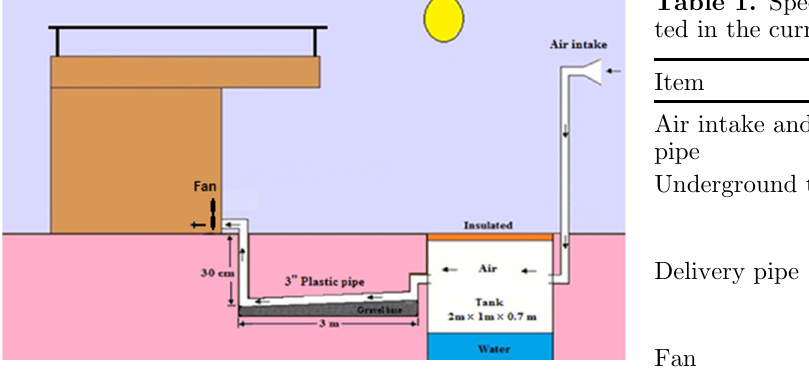
Fig. 2. Scheme of the ef fi cient model.